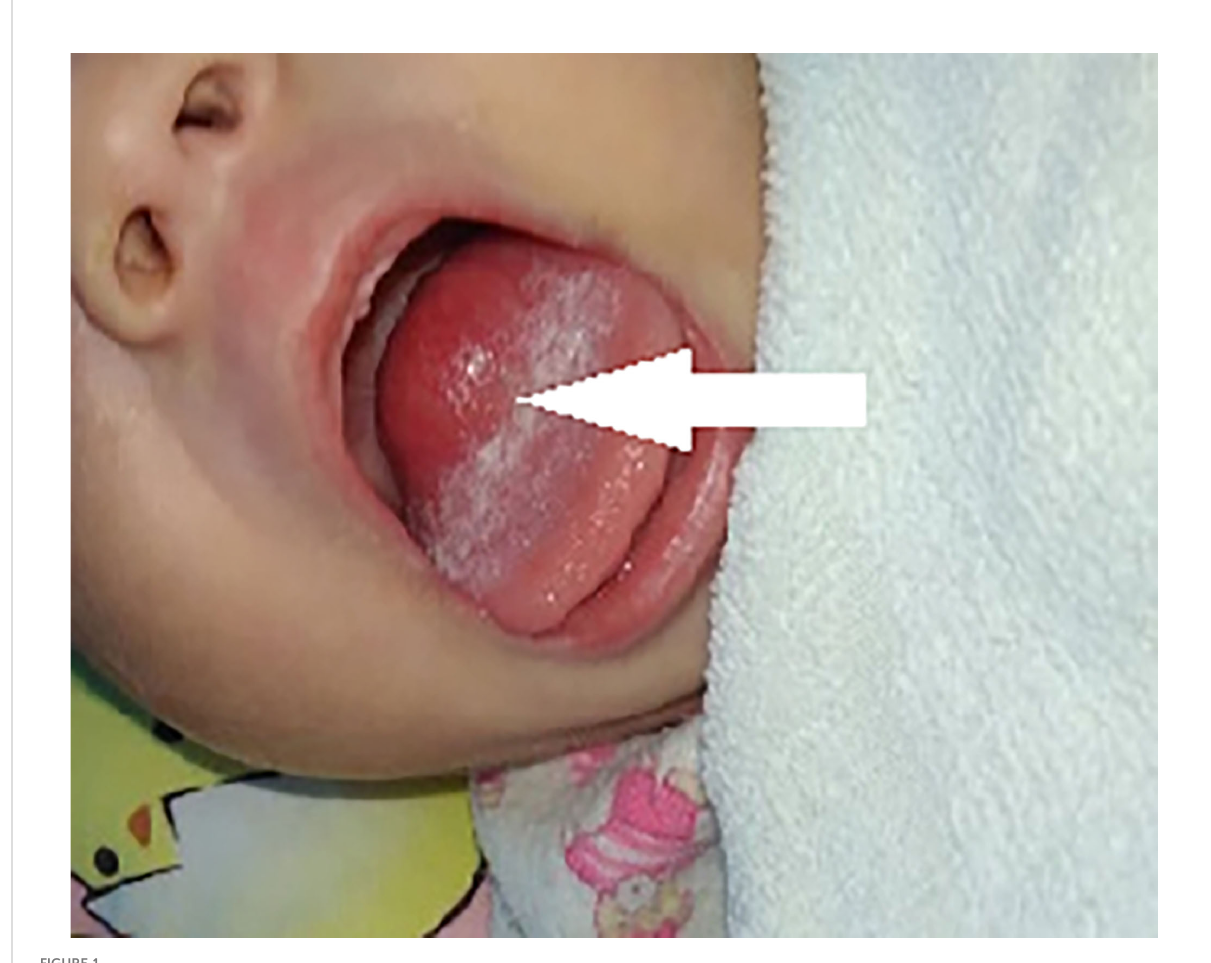
FIGURE 1 Case 2, tongue appearance at